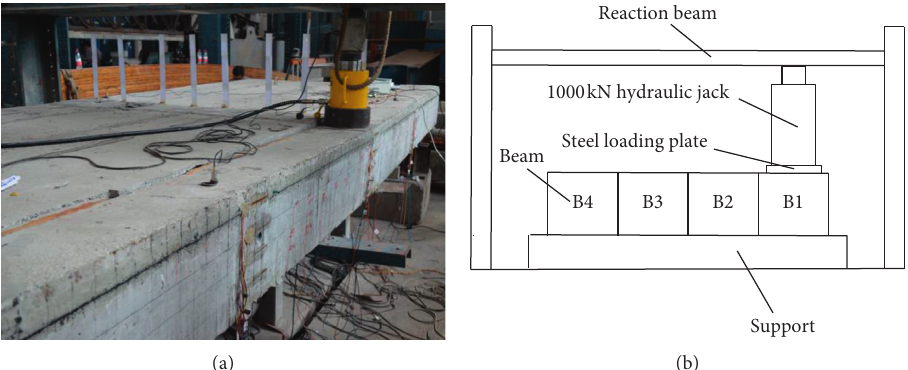
Figure 6: View of loading layout for the destructive test on the model bridge (the edge joint has cracked over loading). (a) Loading layout. (b) Elevation